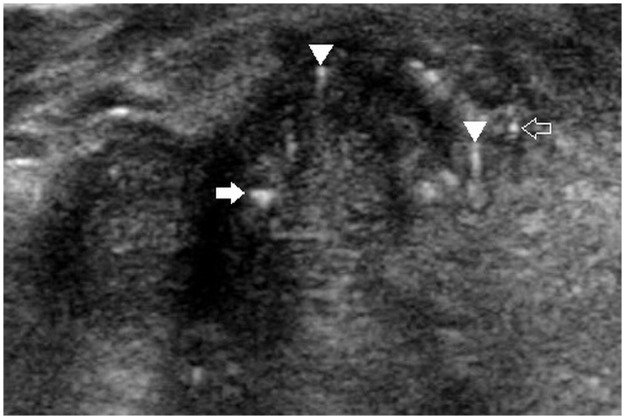
A 52-year-old woman with papillary thyroid carcinoma.Longitudinal sonogram showing a 45-mm, ill-defined, hypoechoic solid nodule in the right thyroid lobe. A linear echogenic focus with reverse-triangle artifact (solid arrow), and a round echogenic focus with fine artifact (arrowhead), and a punctate echogenic foci (faint arrow) are seen (Type 3).